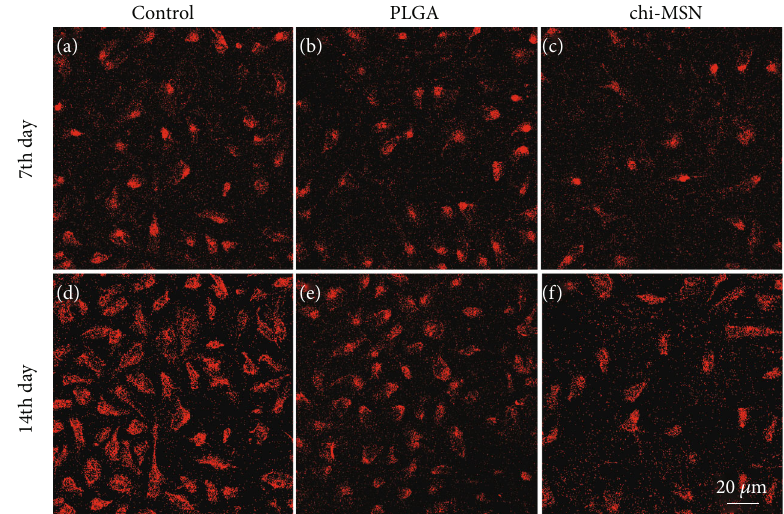
Figure 5: BMSC apoptosis detection. (a – c) Anti-caspase 3 expression in control, PLGA, and Chi-MSN groups at 7th day. (d – f) Anti-caspase 3 expression in control, PLGA, and Chi-MSN groups at 14th